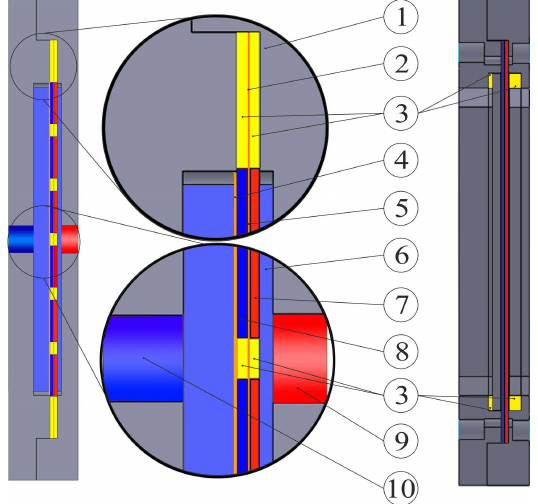
Fig. 3. View of the layers of the PV-T panel cooled with minichannels: 1 – cover (aluminium), 2 – middle plate (copper), 3 – silicone gasket, 4 – outer plate (copper), 6 – PV cell panel, 7 – ‘hot’ minichanel, 8 – ‘cold’ minichanel, 9 – inlet/outlet of the ‘hot’ minichanel, 10 – inlet/outlet of the ‘cold’ minichanel. Two selected minichannels of each type are